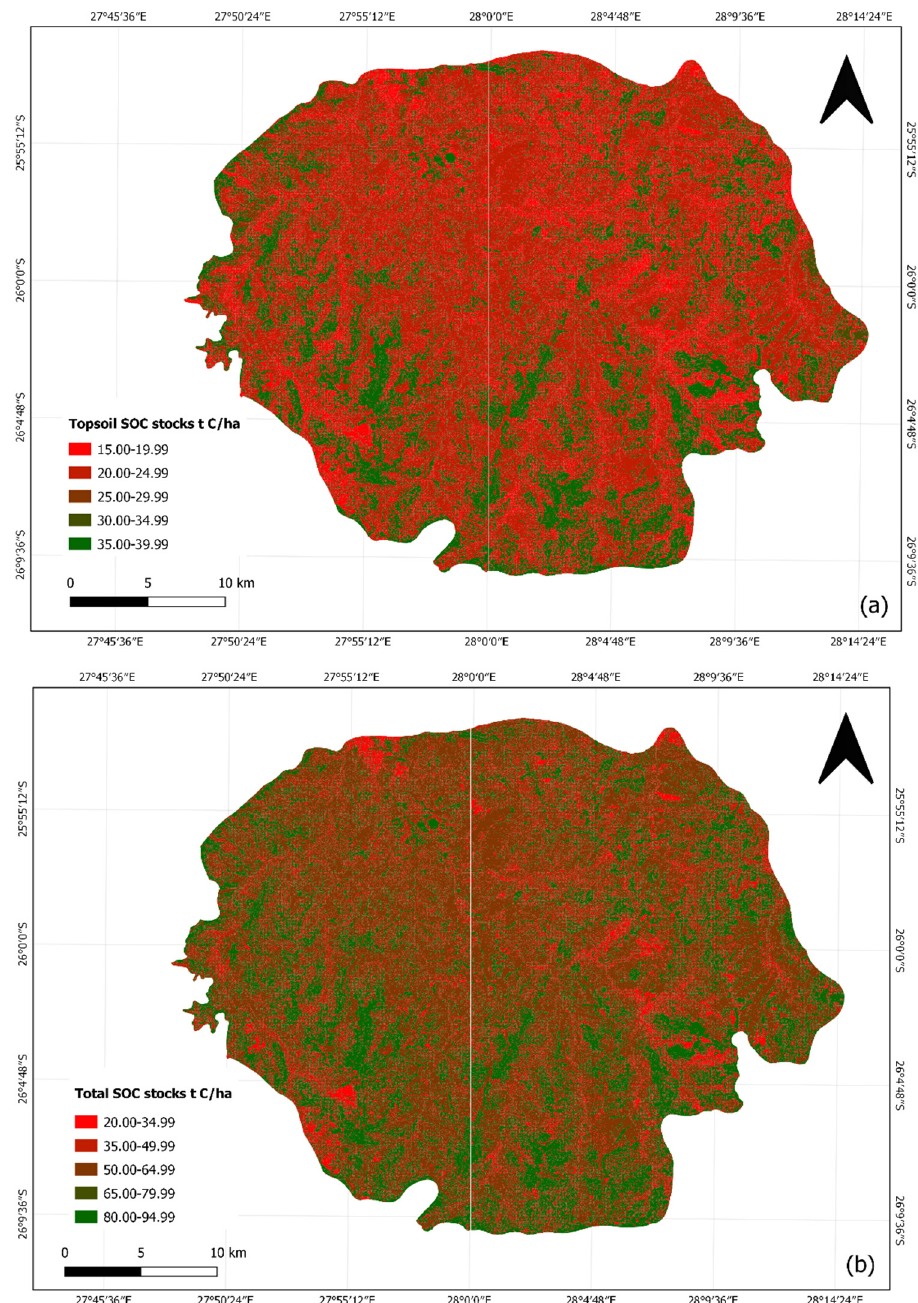
Figure 3. The spatial distribution of soil carbon stocks within ( a ) the A horizon; and ( b ) the entire soil profile.